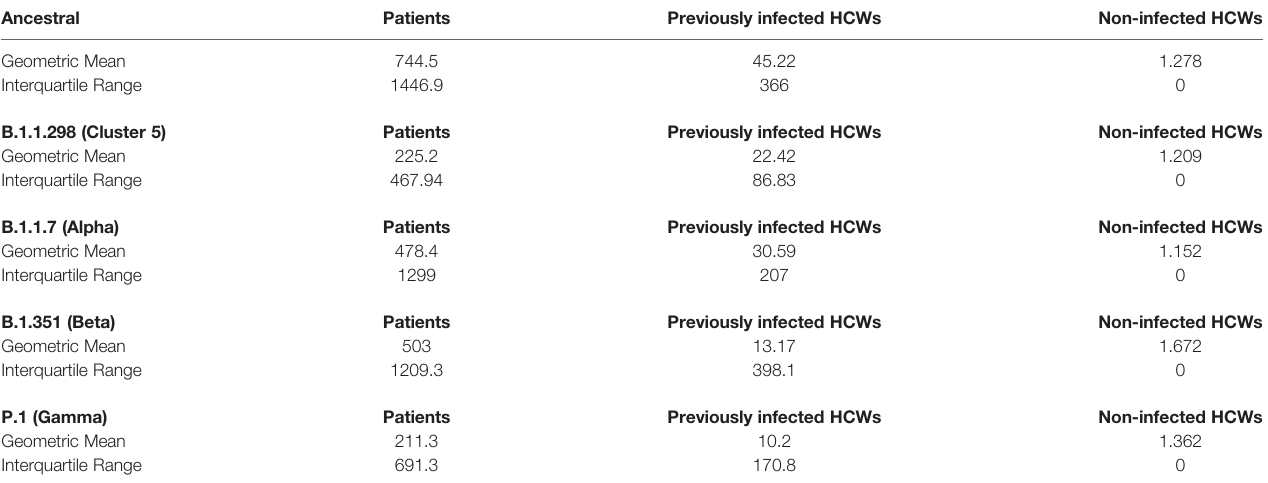
TABLE 3 | Sub-cohort geometric means and interquartile ranges expressed in international units (IU/ml).